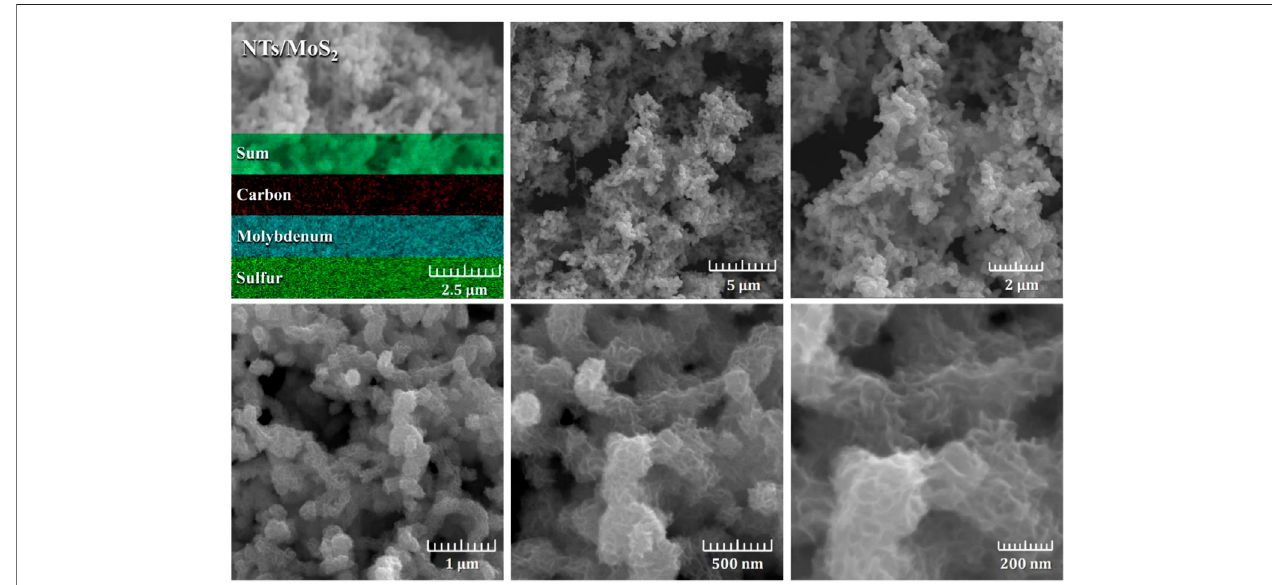
FIGURE 4 | EDS and SEM images of NTs/MoS 2 at different magni fi cations.